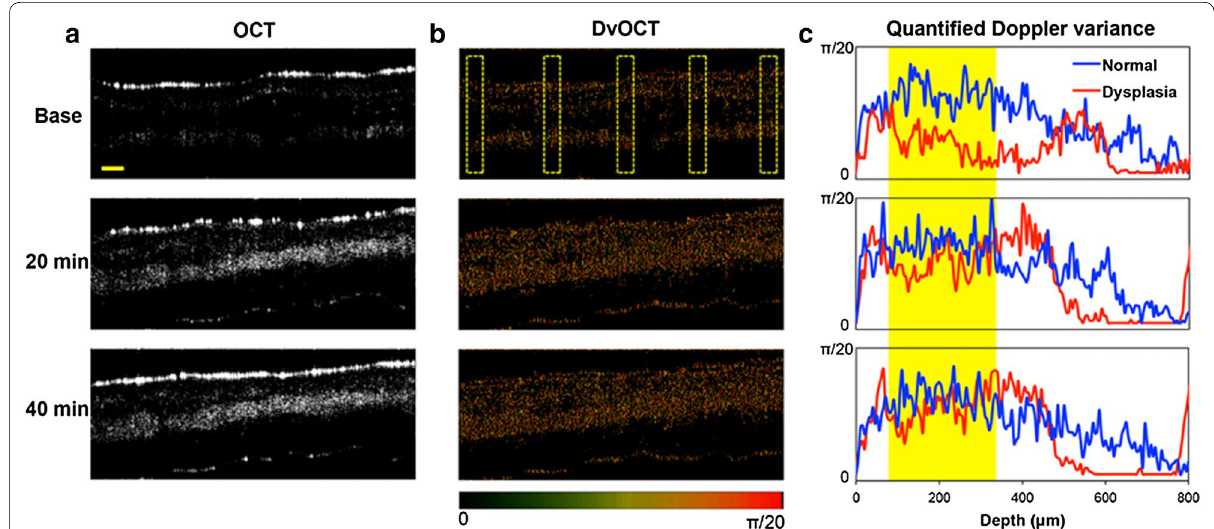
Fig. 9 OCT and DvOCT imaging of dysplastic hamster check pouch with non‑acid‑disassembling Au NCs. Images of DMBA‑applied, early‑stage dysplastic hamster cheek pouches, obtained by SD‑OCT ( a ) and DvOCT ( b ) after administering non‑acid‑disassembling Au NCs. Scale bar: 100 µm. The images were taken before (base) and 20 and 40 min after administering non‑acid‑disassembling Au NCs. The color‑coded Doppler variance in DvOCT images of early‑stage dysplasia (5 dotted regions) was quantified and compared with that of normal tissue ( c ) (yellow area: epithelial